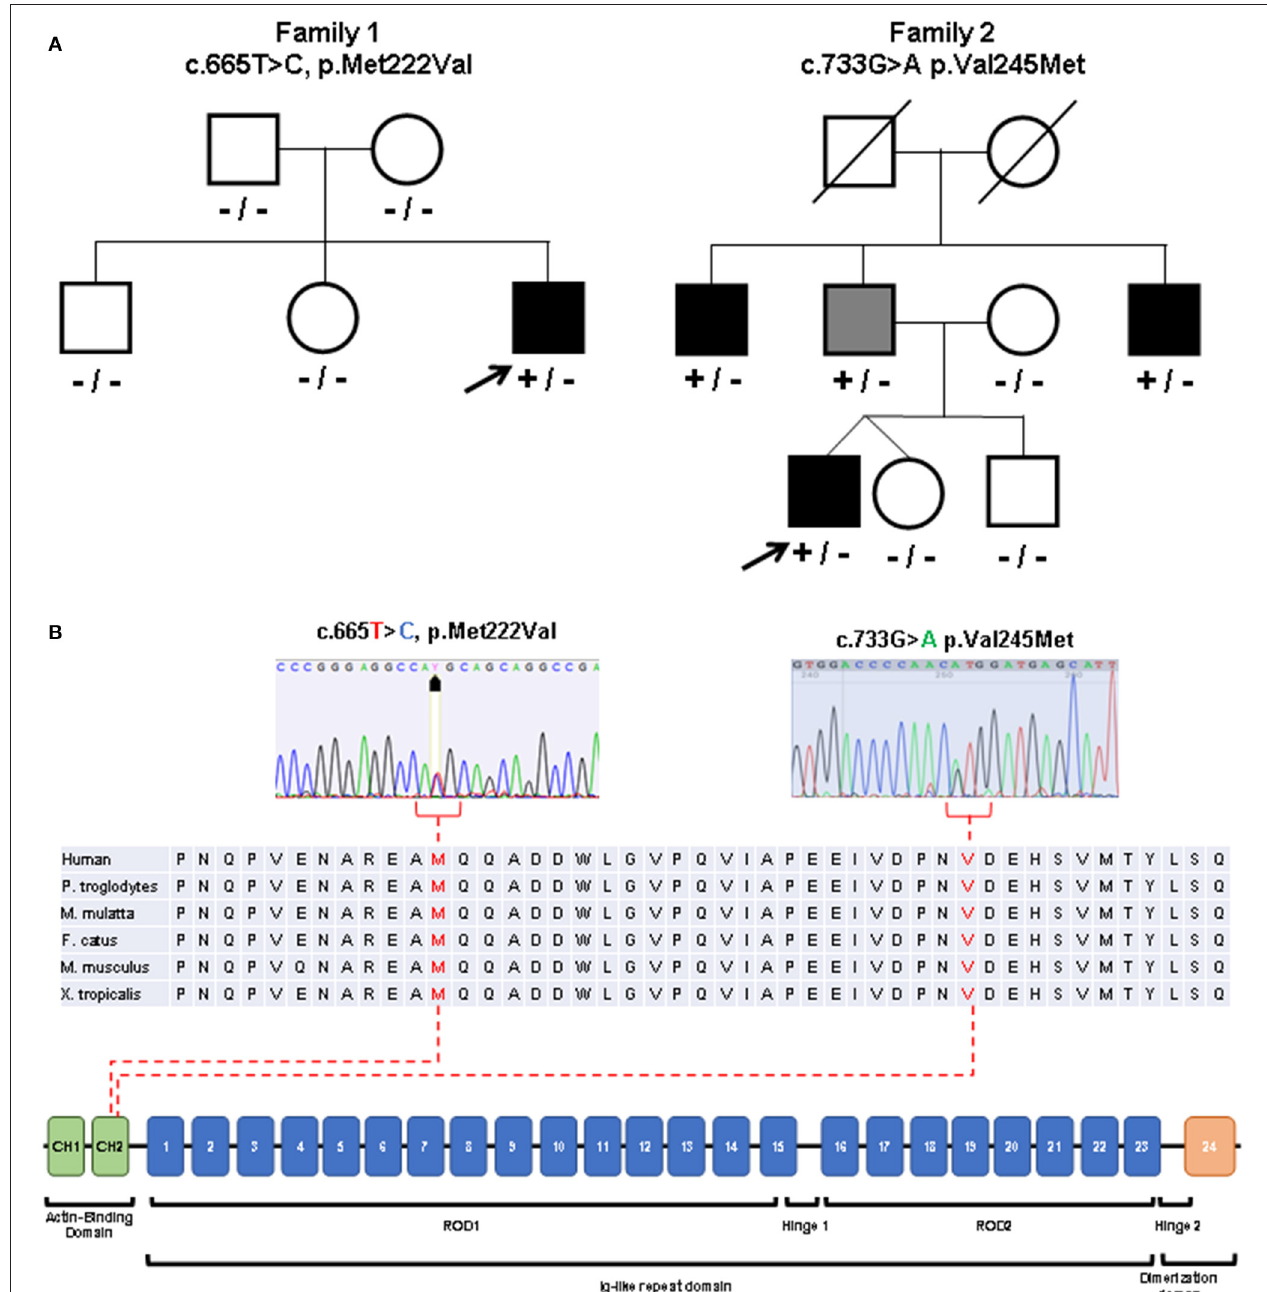
FIGURE 3 | Molecular studies. (A) Pedigrees of the described families. Index patients are indicated with arrows. Black symbols indicate clinically affected subjects. Gray symbol indicates subclinical involvement. Available genotypes are reported under the corresponding subjects. [ (B) , top] Variants identified in the patients (sequence electropherograms) affecting conserved amino acidic residues within the actin binding domain. [ (B) , bottom] Diagram showing the structure of FLNC gene and the protein domains observed in the encoded protein (Filamin-c).